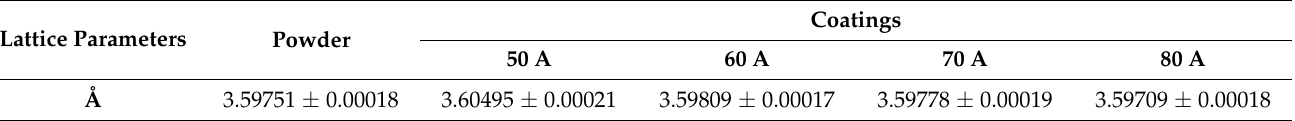
Figure 7. XRD patterns of the HEA coatings. Table 5. Lattice parameters of the CoCrFeNiMn HEA powder and coatings prepared at different plasma arc currents. Lattice